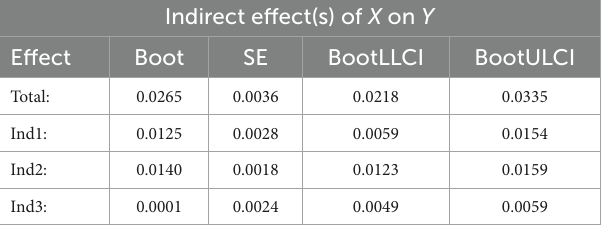
TABLE 7 The mediation pathway